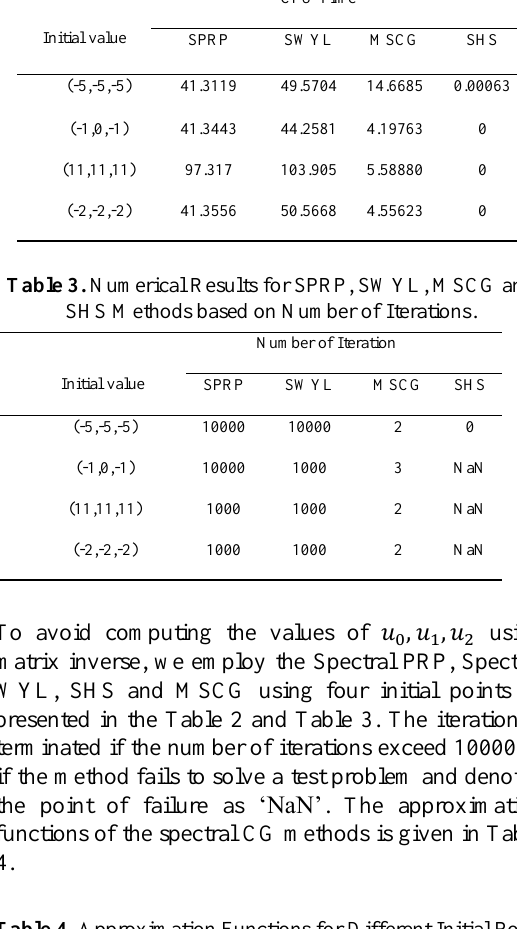
Table 4. Approximation Functions for Different Initial Point